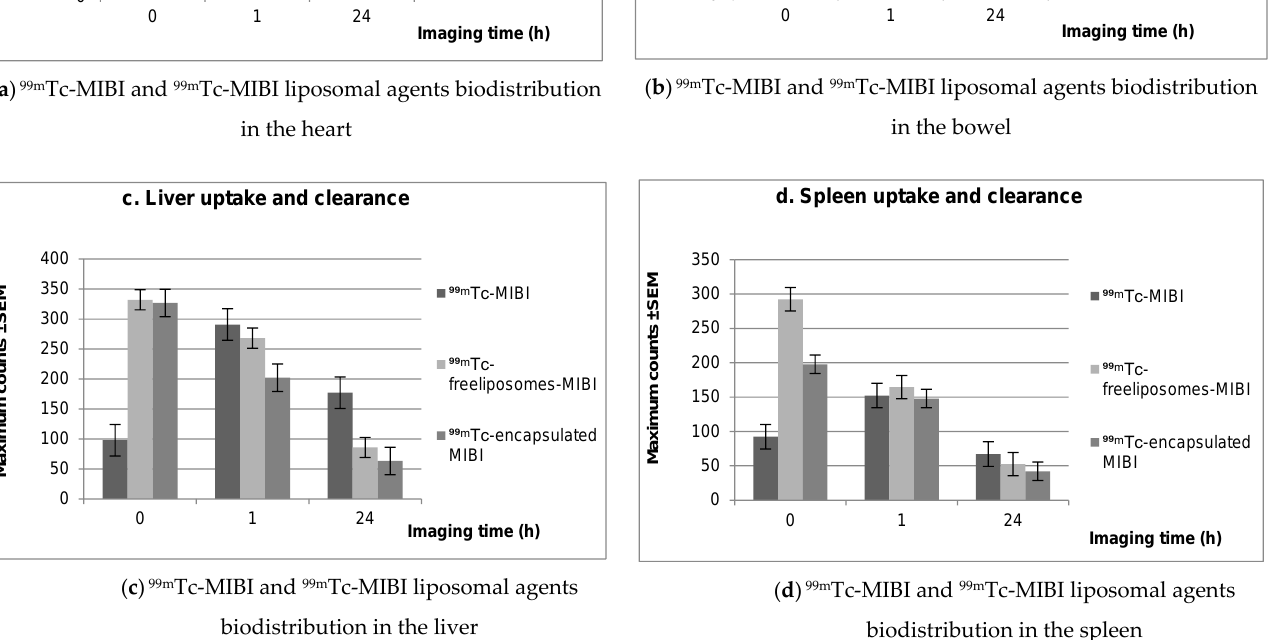
Table 2. Biodistribution of 99m Tc-MIBI compared to that of 99m Tc-liposomal agents in different or- gans at 1 h post-injection.